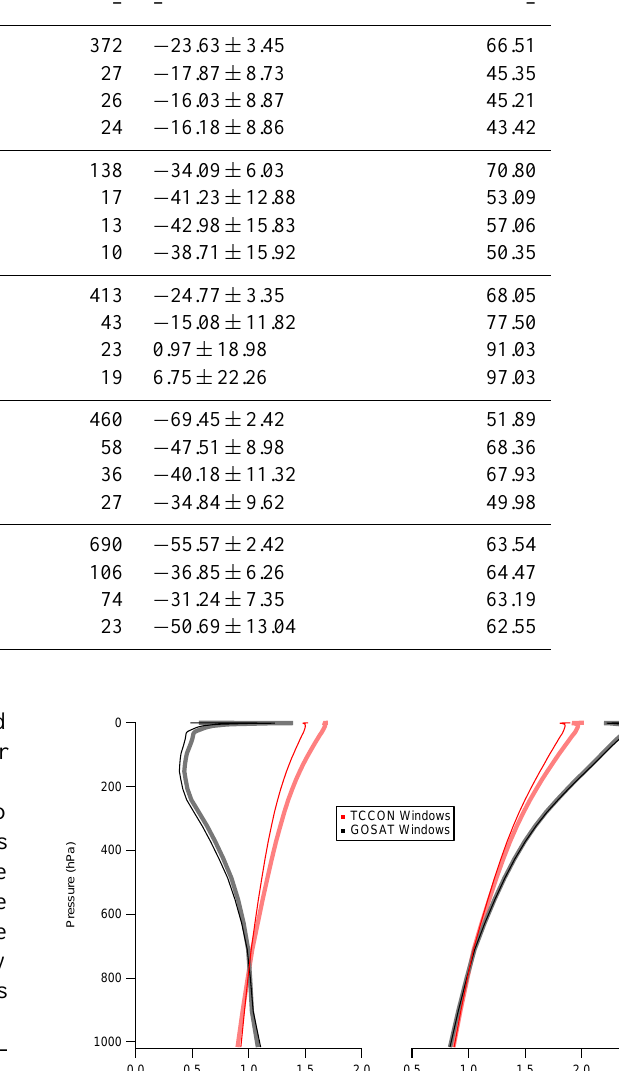
2.52.01.51.00.5 kernel2.01.51.00.50.0 HDO column averaging H 2 O column averaging kernel Fig. 7. Column averaging kernel for the TCCON H 2 O and HDO re- trieval over Orleans, France, on 31 July 2010. Shown are the kernels Fig. 7. Column averaging kernel for the TCCON H 2 O and HDO for a SZA of 30 ◦ (thick lines) and 60 ◦ (thin lines). The red lines are retrtieval over Orleans, France on 31 July 2010. Shown are the for the TCCON fit windows and the black lines for the GOSAT fit kernels for a SZA of 30 (cid:14) (thick lines) and 60 (cid:14) (thin lines). The red lines are for the TCCON fit windows and the black lines for the GOSAT fit window.